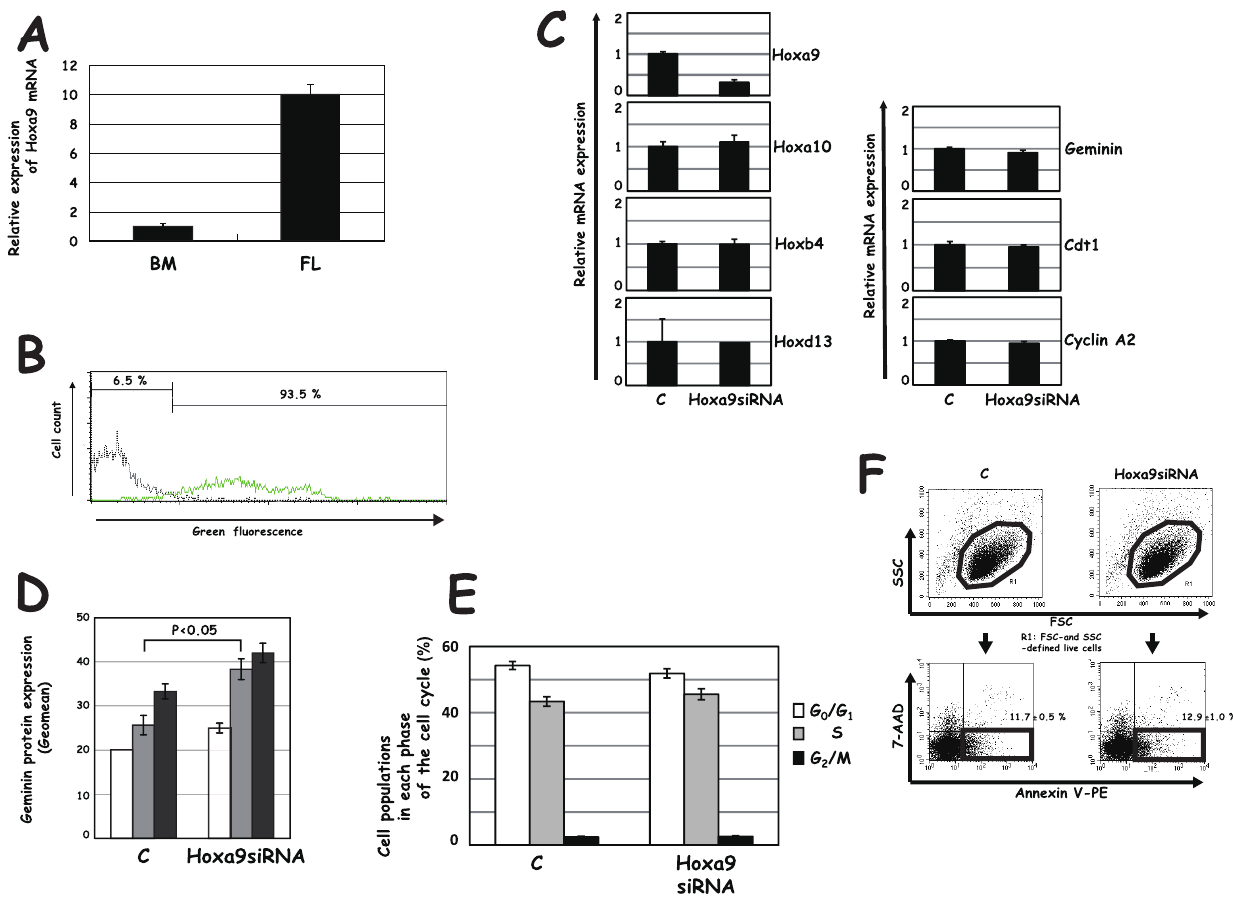
Figure 5. Expression of Hoxa9 in hematopoietic cells, and effect of siRNA-mediated Hoxa9 knock-down on Geminin expression in FL. ( A ) Expression of Hoxa9 mRNA in BM and FL. ( B ) Efficiency of siRNA transfection into FL. Hoxa9siRNA was co-transfected with either non-labeled non-targeting (dotted line) or green fluorescent dye-labeled non-targeting siRNA (green line) as an indicator to monitor the transfection efficiency. High transfection efficiency was confirmed by detecting expression of the indicator by flow cytometry. Rate of a green-fluorescence + or green- fluorescence 2 subpopulation (%) in the transfectants is shown in the upper part of the panel. ( C ) Effect of Hoxa9 siRNA transfection on expression of mRNA for Hoxa9, Hoxa10, Hoxb4, Hoxd13, Geminin, Cdt1 and Cyclin A2. Specific knock-down of Hoxa9 mRNA expression was confirmed by real-time PCR analysis. Hoxa9siRNA, siRNA for Hoxa9; C, non-targeting control siRNA. ( D ) Effect of siRNA transfection on Geminin protein expression in each phase of the cell cycle. Geomean of fluorescence intensity for Geminin protein was shown. ( E ) Effect of siRNA transfection on cell cycle. ( F ) Effect of siRNA transfection on apoptosis. The data from three independent experiments were subjected to the statistical analysis. The representative cell sorting data are